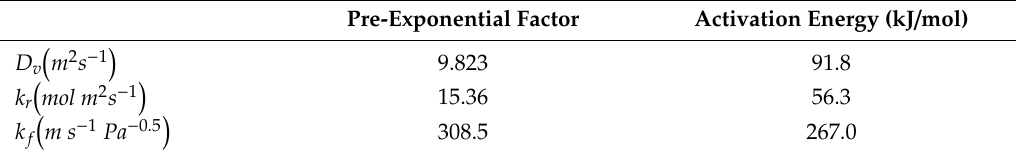
Table 5. Values of the permeability parameters resulting from the fitting of experimental data